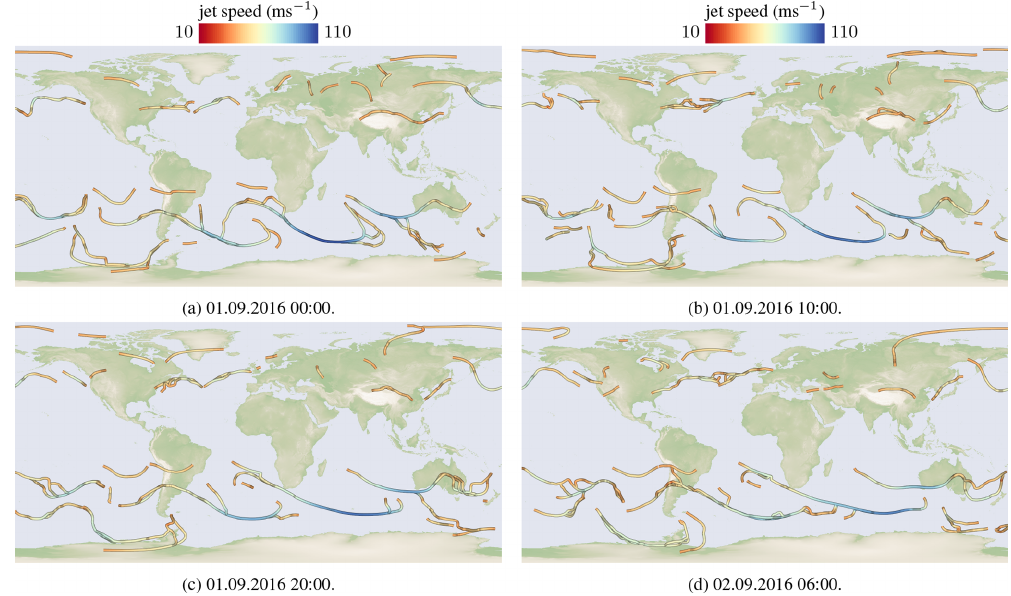
Figure 3. Temporal tracking of the jet stream. Here, shown for four time steps with an integration step size of 10h between 1 September 2016 at 00:00UTC and 2 September 2016 at 06:00UTC. Especially the fast-moving wind speeds (blue structures) are tracked coherently over time. Table 1. The extraction time in seconds when changing one parameter value while keeping the others fixed, listed here for the default parameters and two variations from the default parameters. Increasing n stepsBelowThresh prolongs the integration duration since longer lines emerge. Increasing n predSteps per iteration traces out the jet lines with less iterations. The smaller τ wind (in ms − 1 ), the more lines are traced. With lower n corrSteps , less jets merge, causing higher tracing cost. For higher n corrSteps , the runtime increases linearly due to more steps. Parameter Parameter value Extraction time (s) Default Variation 1 Variation 2 Default Variation 1 Variation 2 τ wind 40